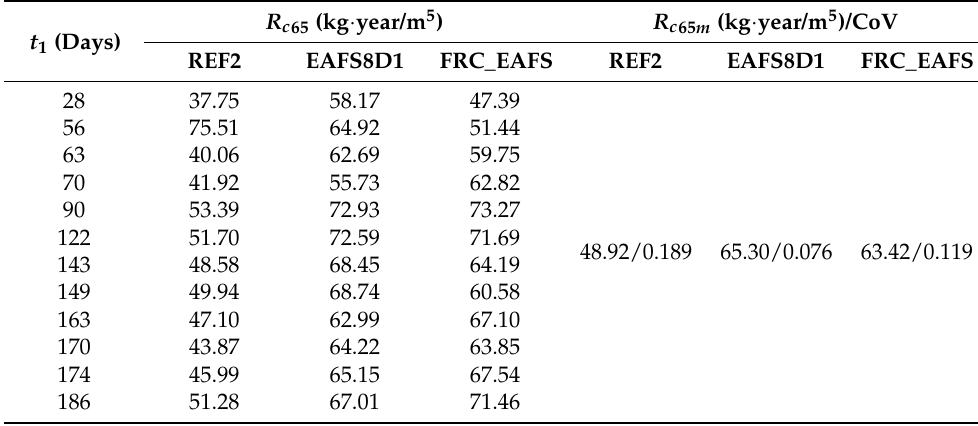
Table 20. Results of carbonation resistance, R c 65 , for the REF2 mixture and for the mixtures designed with EAFS and